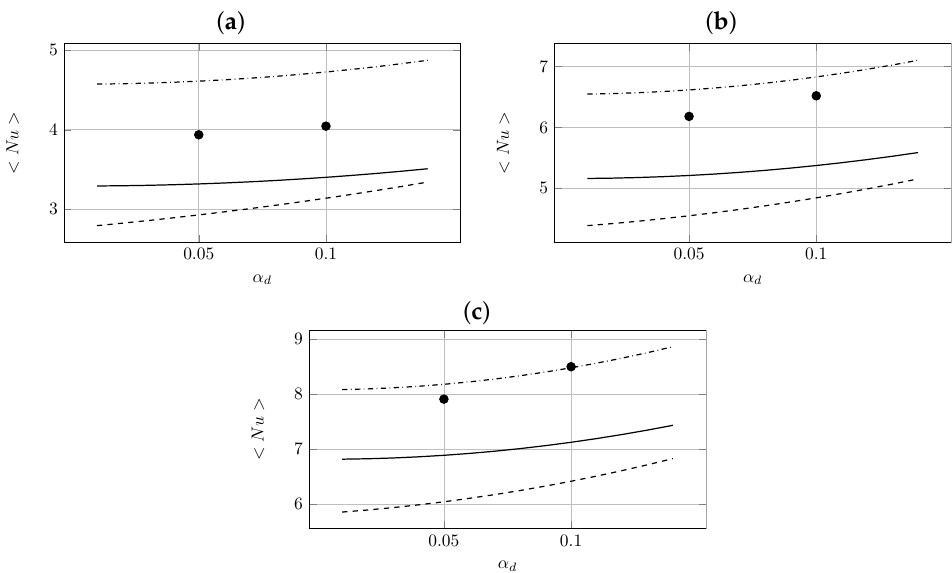
Figure 13. Nusselt coefficient for a uniform flow past a random arrangement of hot spheres as a function of the solid volume fraction α d at vatious Reynolds numbers ( a ) Re = 10, ( b ) Re =